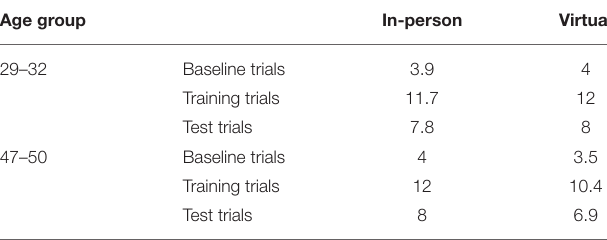
TABLE 2 | Number of analyzable